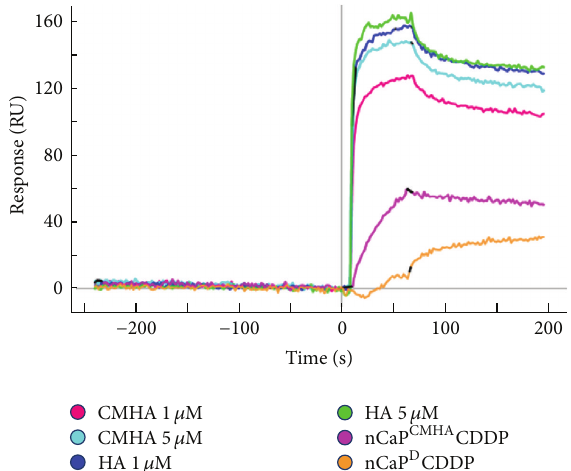
Figure 4: Surface plasmon resonance sensogram depicting binding of CMHA, HA, and nCaP CMHA CDDP with immobilized CD44. All data shown has been corrected for nonspecific binding to blank channels of blocked NHS-EDC. nCaP D CDDP was used as a comparable sized control,whichdoesnothavespecificinteractionswithCD44.HAhasthehighestaffinityforCD44,followedbyCMHAthennCaP CMHA CDDP.